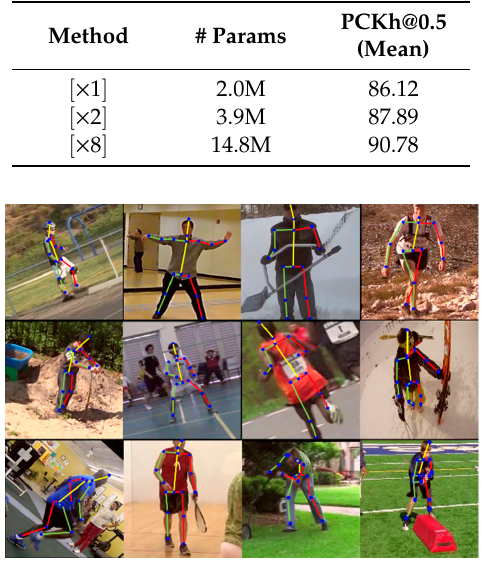
Figure 8. Prediction results of the proposed method for the MPII dataset.